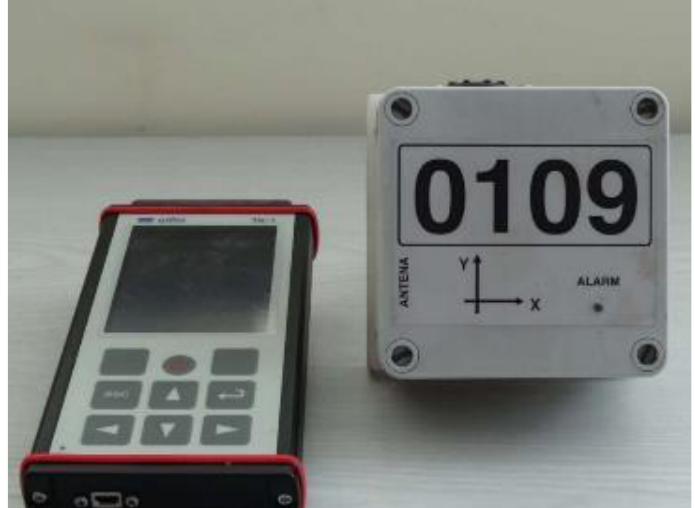
Figure 10. Inclinometric sensor with a wireless data transmitter.